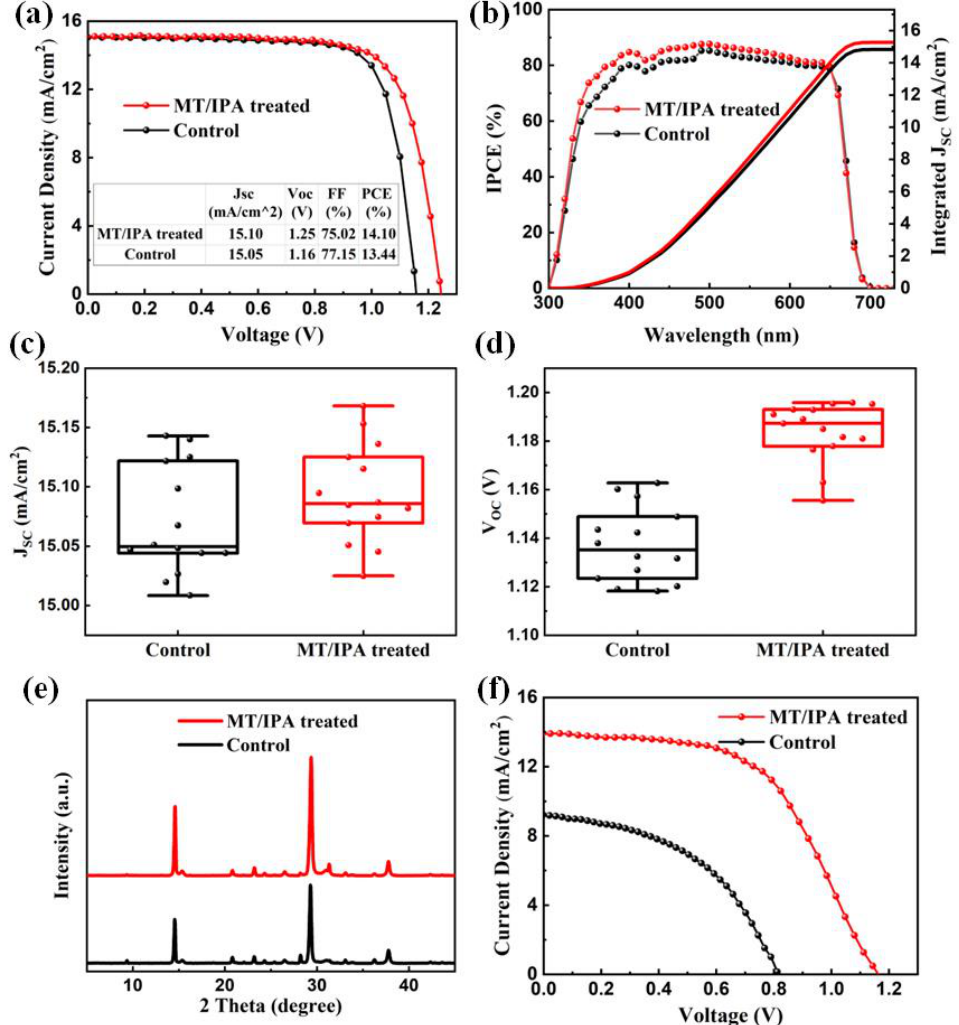
Figure 5. ( a ) J–V curves of the untreated and MT/IPA-treated solar cells. ( b ) IPCE curves of the untreated and MT/IPA-treated champion solar cells. The distribution box diagrams of ( c ) J sc and ( d ) V oc of the untreated and MT/IPA-treated devices. ( e ) XRD spectra of untreated and MT/IPA-treated perovskite films prepared in the air. ( f ) J–V curves of untreated and MT/IPA-treated 2D/3D perovskite cells prepared in the